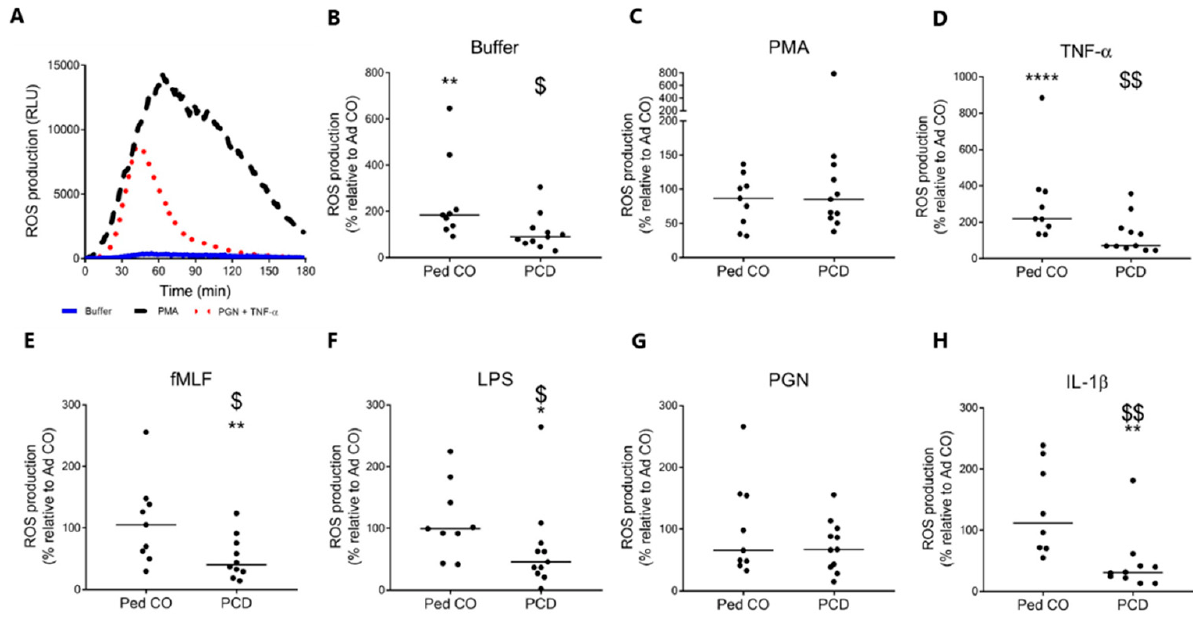
Figure 6. Circulating PMNs from patients with PCD produce less reactive oxygen species compared to PMNs from healthy controls. The production of reactive oxygen species (ROS) by PMNs isolated from patients with PCD (PCD, n = 9–11 [7–9 pediatric and 2 adult]), age-matched healthy pediatric controls (Ped CO, n = 8–9) and healthy adult controls (Ad CO, n = 9–11) was measured by chemiluminescence for 3 h. ( A ) A representative graph of ROS production by PMNs from an Ad CO (relative light units, RLU). ROS production was measured after stimulation with ( B ) buffer or ( C ) PMA (30 nM), which was considered as positive control. Prior to stimulation, PMNs were primed with ( D ) TNF- α (50 ng/mL) for 10 min at 37 ◦ C. Afterwards, PMNs were stimulated with ( E ) fMLF (10 − 7 M), ( F ) LPS (10 µ g/mL), ( G ) PGN (10 µ g/mL) or ( H ) IL-1 β (500 ng/mL). Each dot represents the fold change in ROS production by PMNs from patients and Ped CO relative to the fold change in ROS production of the reference Ad CO (%). Statistical differences were determined by the Mann Whitney U-test (Ad CO versus PCD or Ped CO: * p < 0.05, ** p < 0.01, **** p < 0.0001; Ped CO versus PCD: $ p < 0.05, $$ p < 0.01).